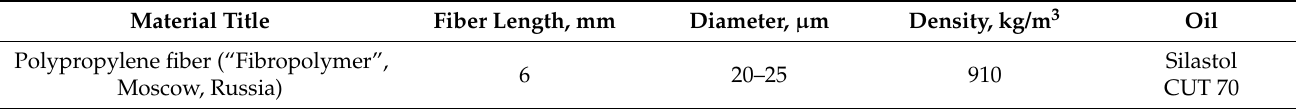
Table 3. Characteristics of polypropylene fiber.